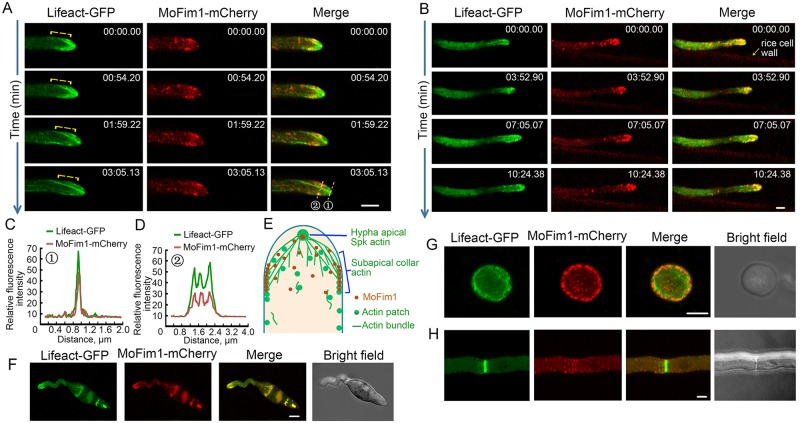
Localization of MoFim1 in M. oryzae.(A and B) Expression of pMoFim1-MoFim1-mCherry in Lifeact-GFP-labeled Mofim1 mutant vegetative (A) and invasive (B) hyphae. The numbers at the top right corner indicate the timestamps (min:s). The yellow brackets indicate the subapical collar region. Bars = 2 μm. (C and D) Line-scan analysis of the localization of MoFim1 related to the actin cytoskeleton. (E) Localization of MoFim1 in the hyphal tip. (F–H) Localization of MoFim1 in the M. oryzae germ tube (F), appressorium (G), and septum (H). Bars = 5 μm.